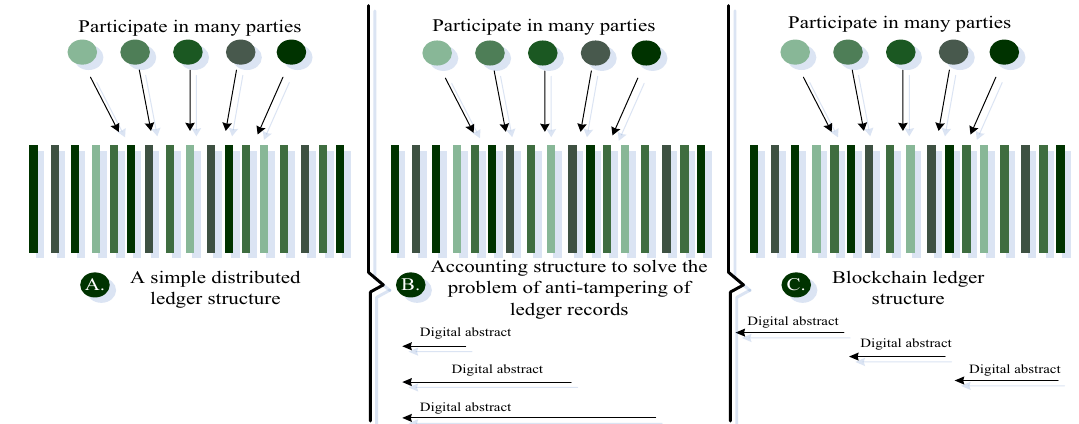
Fig. 3 Various ledger